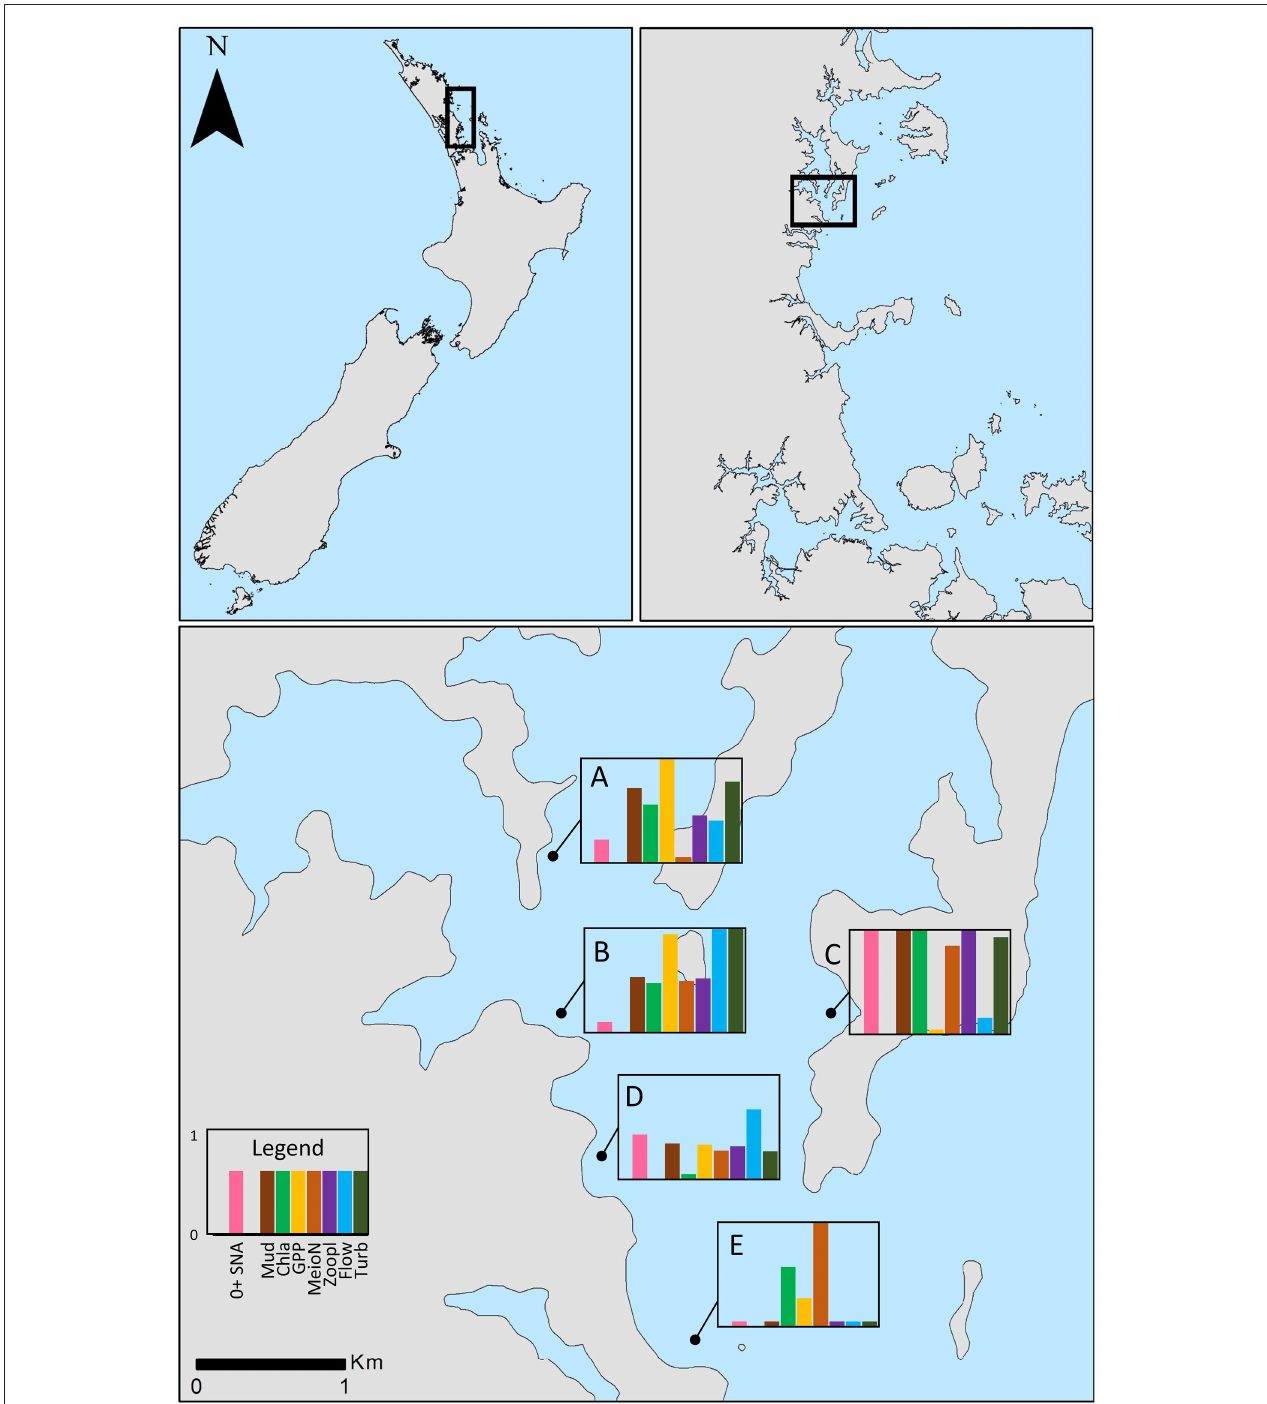
FIGURE 1 | New Zealand (upper left) and the region north of Auckland (upper right) where the study was conducted. Bottom panel shows the positions of the five study sites in Mahurangi Harbor. Water depth at high tide was 5–8m at all sites; only a small portion of the main harbor channel near the mouth is > 10m water depth. Bar graphs depict the relative importance of habitat structure to post-settlement snapper (pink bars = abundance of snapper amongst structure minus abundance in control plots, SNA diff) and the relative magnitudes of selected environmental variables (see legend) across sites. All variables were standardized to run from 0 to 1 for ease of comparison. Mud, sediment mud content (%); Chl a , sediment chlorophyll a content ( µ g g − 1 ); GPP, gross primary production ( µ mol O 2 m − 2 h − 1 ); MeioN, abundance of meiofauna per core (ostracods, nematodes, and benthic copepods); Zoopl, abundance of zooplankton that dominate post-settlement snapper diet found in bottom water; Flow, average current velocity (m s − 1 ); Turb, light attenuation coefficient, K d , a proxy for turbidity.